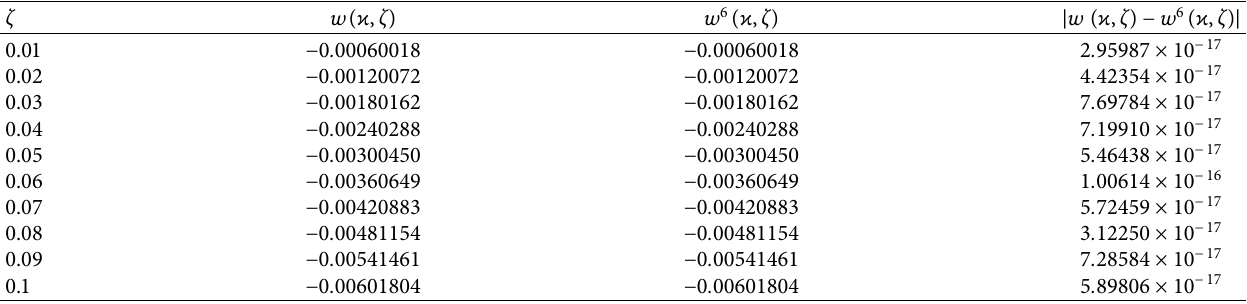
Table 9: | w ( ϰ , ζ ) − w 6 ( ϰ , ζ )| of Problem 2 at ϰ � 1 . 0 when ϖ � 1 . 0 determined by LRPSM at plausible locations in the range ζ ∈ [ 0 , 0 . 1 ] .